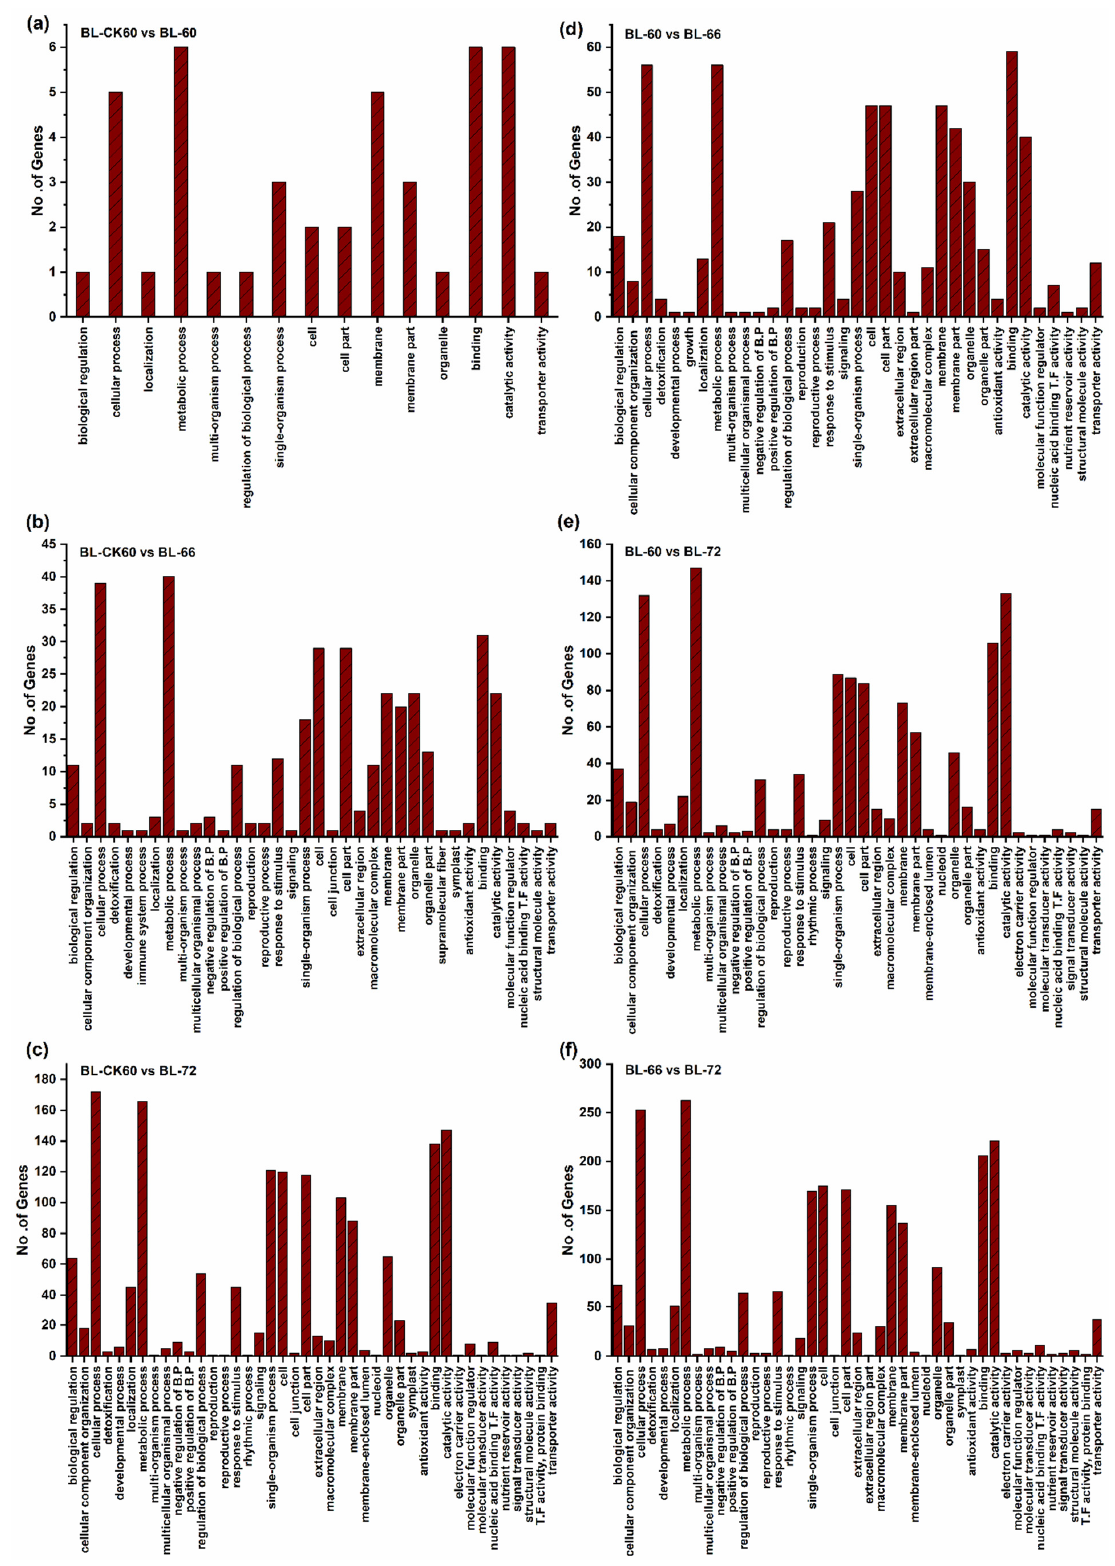
Figure 3. Biological process analysis of DEGs between control and treatment, and among treatments at three tested time points (60 h, 66 h, and 72 h); ( a – c ) Biological process analysis of DEGs between control and treatment at tested time points (60 h, 66 h, 72 h); ( d – f ) Biological process analysis of DEGs among treatment comparisons at tested time points (60 h, 66 h, 72